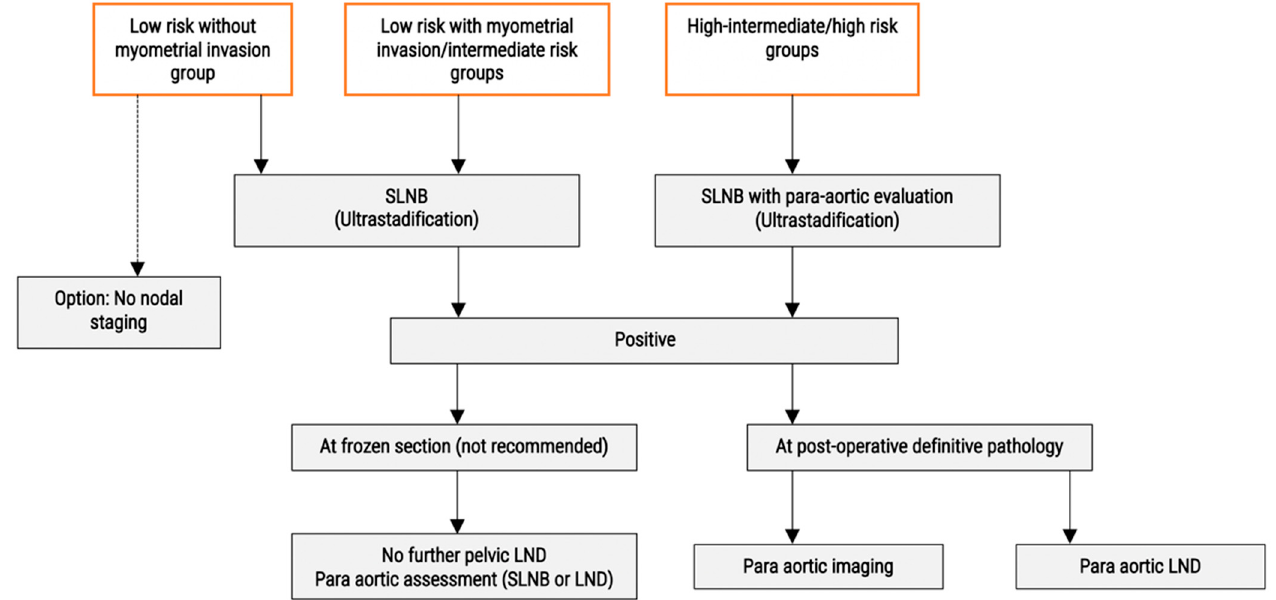
Figure 3. Proposed algorithms for the nodal management in early stages endometrial cancer. SNLB: Sentinel Lymph Node Biopsy; LND Lymph Node Dissection.